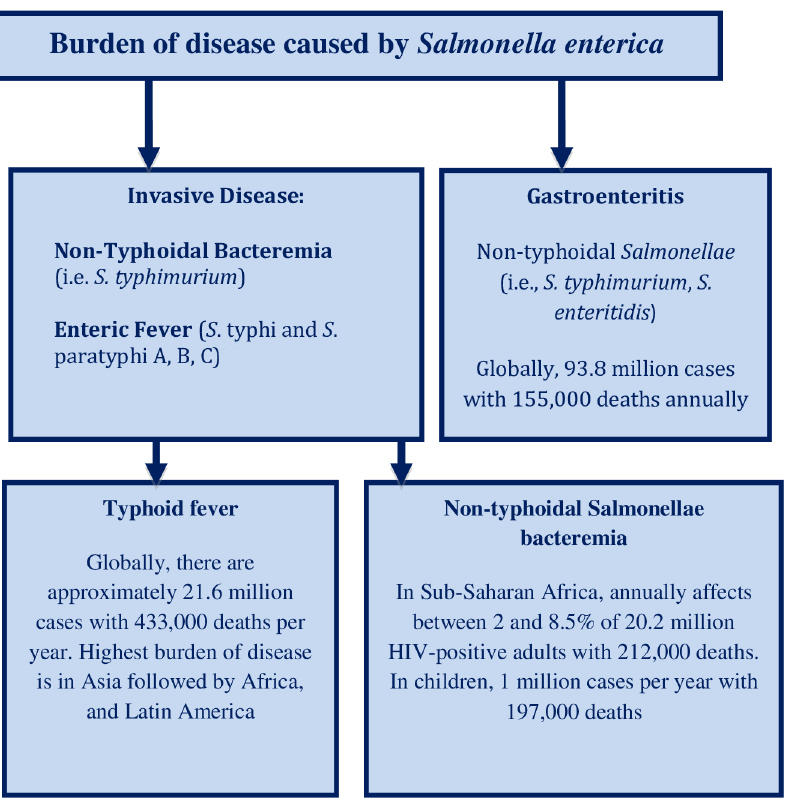
Fig 1. Global estimates of disease caused by Salmonella enterica including enteric fever (typhoid fever and paratyphoid fever), non-typhoidal salmonellosis, and